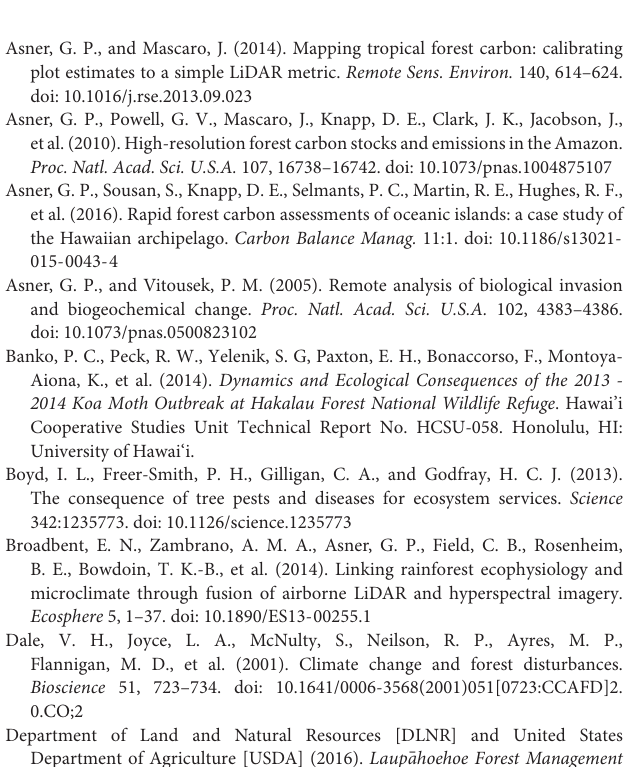
FIGURE S1 | United States drought monitor graph from January 2001 to January 2017 for Hawaii county, highlighting the 2008–2014 drought. Drought classification criteria can be found in Supplementary Table S4. Data obtained from http://droughtmonitor.unl.edu. FIGURE S2 | Mean annual precipitation (MAP) for the study landscape. Data obtained from the Rainfall Atlas of Hawaii http://climate.geography.hawaii.edu/ (Giambelluca et al., 2013). Data was only available up to 2012. The red verticle line denotes the start of the 2008–2014 drought. The solid black horizontal line is the study landscape MAP for the Hawaii Rainfall Atlas 30-years base period (1978–2007). The dashed horizontal lines are one standard deviation from the mean of the base